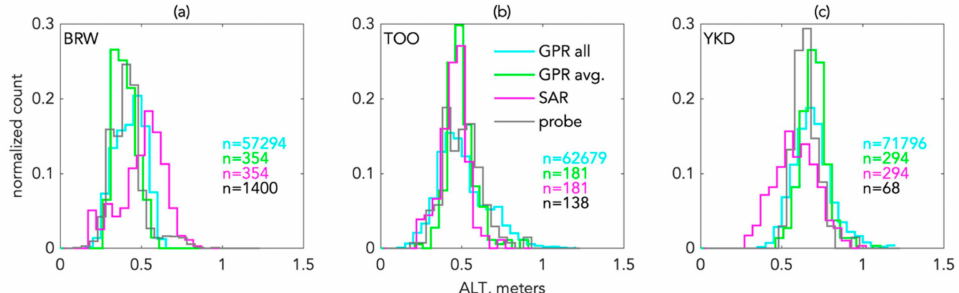
Figure 7. Histograms of ALT for the ( a ) BRW, ( b ) TOO, and ( c ) YKD swaths.